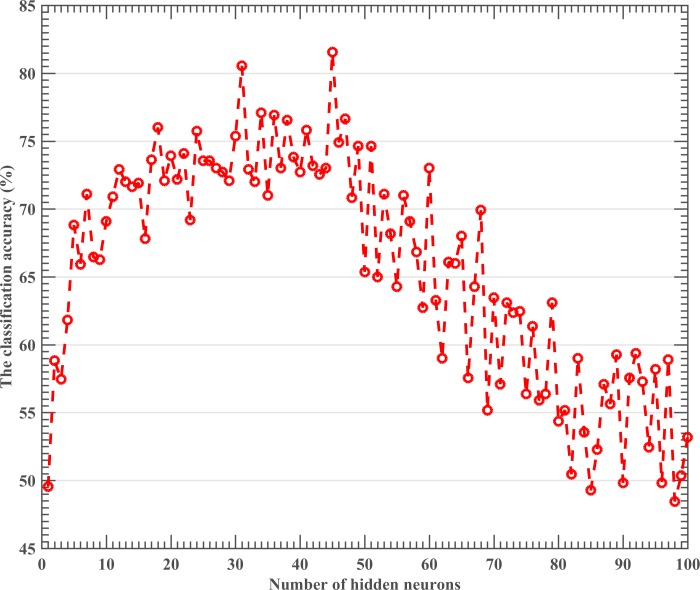
Classification accuracy of ELM versus the number of hidden neurons.